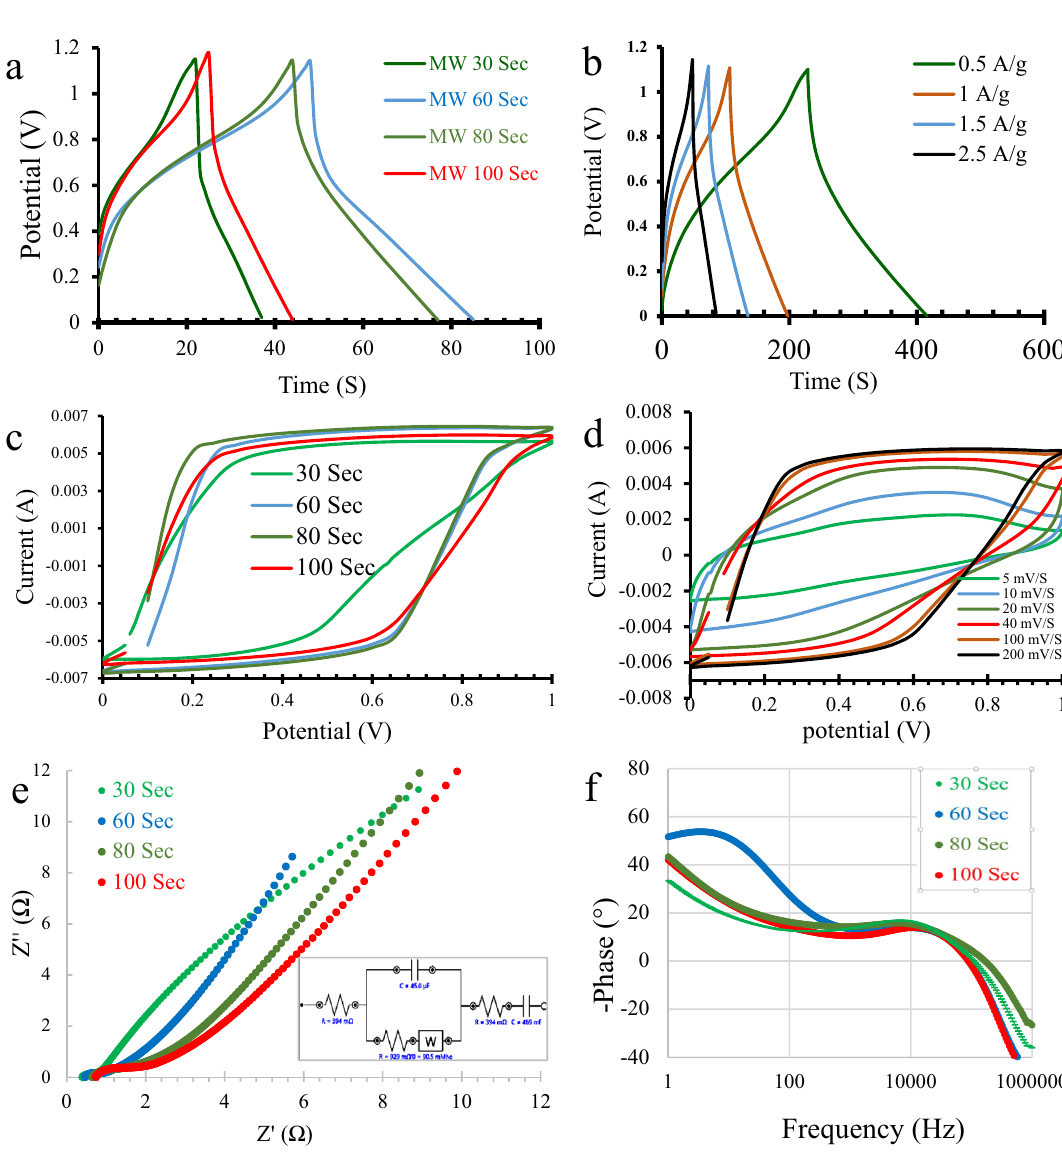
Figure 6. ( a ) charge discharge curves for samples prepared at different MW durations at 2.5 A g −1 , ( b ) charge discharge curves for Fe(60) sample at different currents, ( c ) CV curves for samples prepared at different MW times at 200 mV S −1 , ( d ) CV curves for Fe(60) sample at different scan rates, ( e ) Nyquist plot for samples prepared at different MW durations in an electrochemical capacitor cell. The inset represents the supercapacitor’s equivalent circuit ( f ) bode phase plot for samples prepared at different MW durations in an electrochemical capacitor